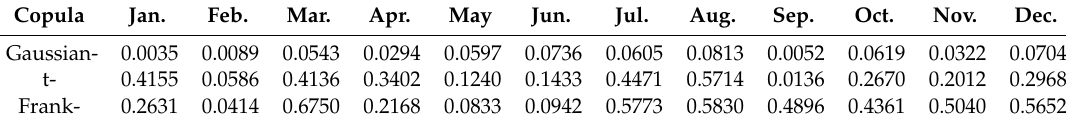
Table 5. The fitting performance results of di ff erent Copula functions.